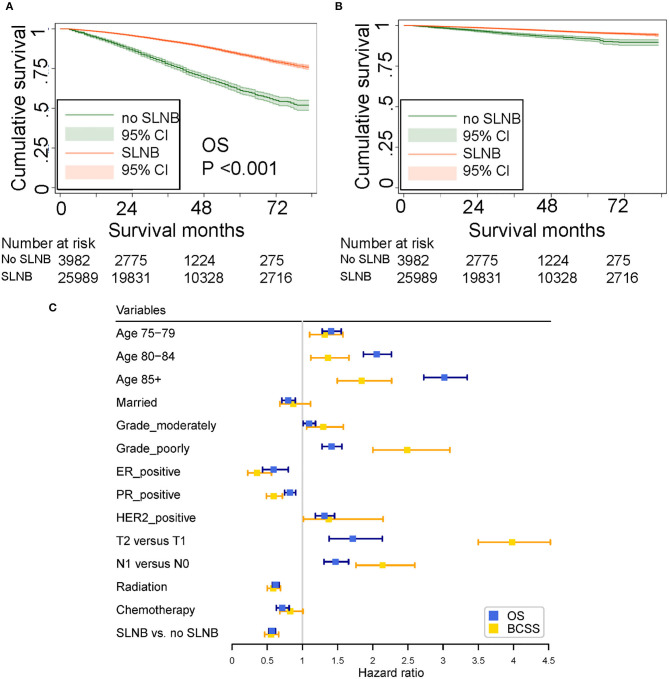
(A) Unadjusted overall survival (OS). (B) Unadjusted breast cancer-specific survival (BCSS) curves plotted by the Kaplan–Meier method for patients who received and did not receive SLNB. (C) Forest plot showing the results of multivariate COX analysis for OS and BCSS.